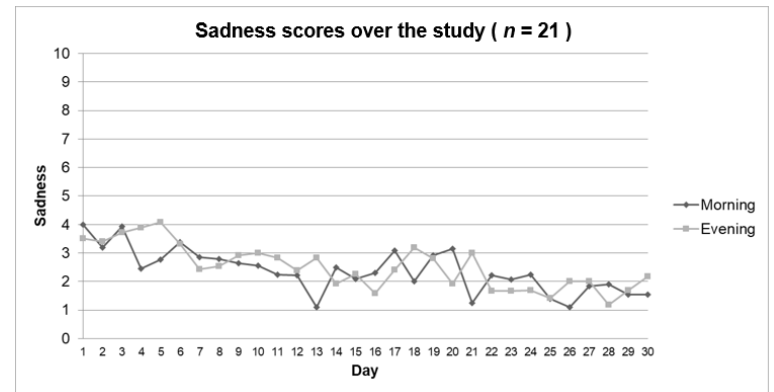
Figure A2. Graphical Representation of Sadness Over the Study.